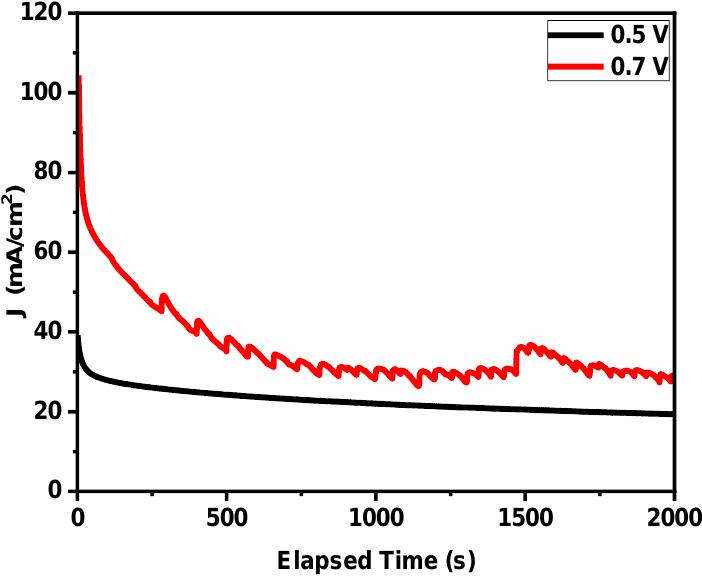
Figure 7. Chronoamperogram for CH 3 OH electrooxidation on NiNPs@PCFs catalyst at potential of